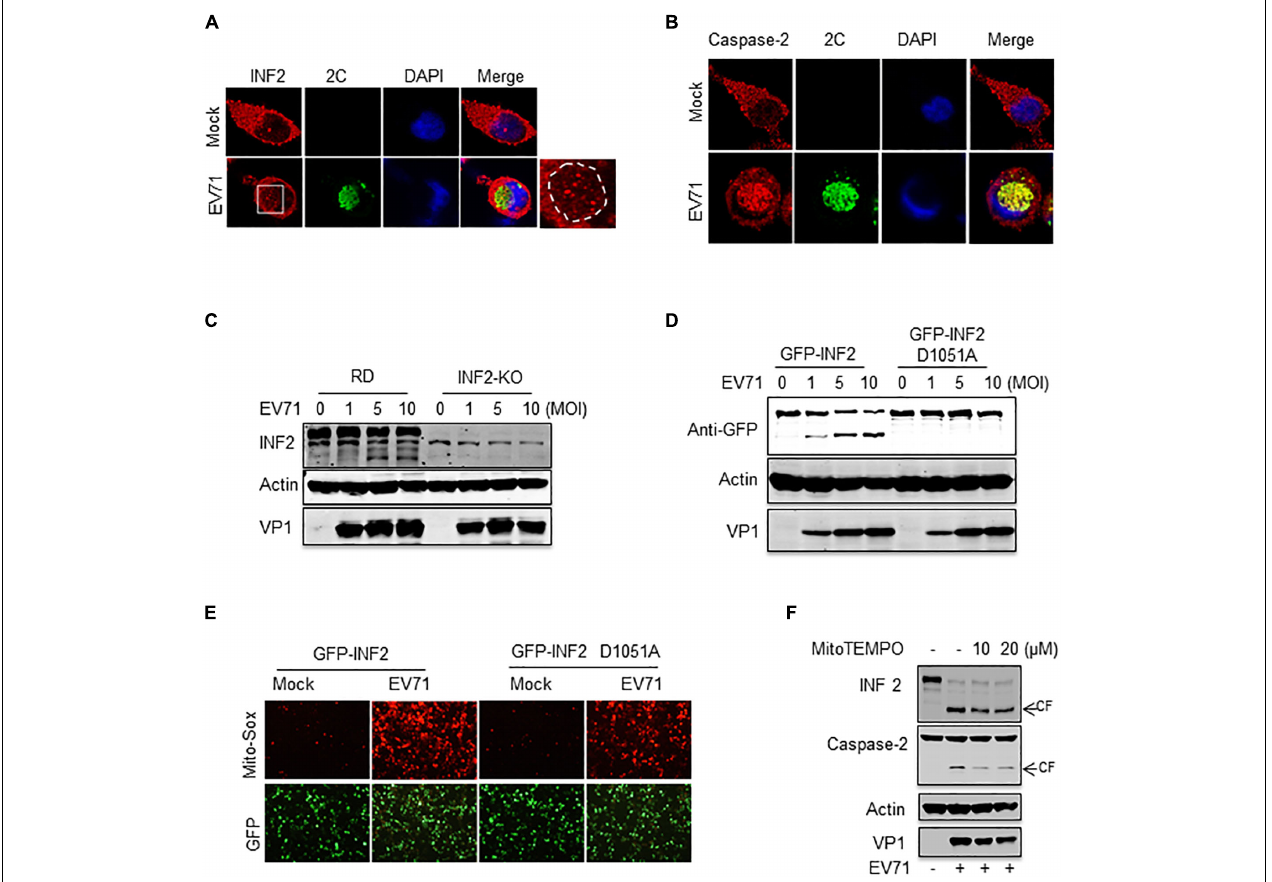
FIGURE 7 | Caspase-2-mediated INF2 cleavage participates in viral replication and is the cause of mitochondrial damage. (A) RD cells were mock-infected or infected with EV71 (MOI = 10) for 12 h, and immunostaining was then performed to detect the intracellular distribution of INF2 and EV71 2C protein (INF2, red; 2C, green; nuclei, blue). Insets show magnified views of the red channel in the boxed region. (B) RD cells were treated as described in (A) , immunostaining was performed to detect the intracellular distribution of caspase-2 and EV71 2C protein (caspase-2, red; 2C, green; nuclei, blue). (C) RD cells and INF2 knockout RD cells (INF2-KO) cells were infected with the indicated dosage of EV71. The cells were then harvested, and Western blotting was performed using the indicated antibodies to detect INF2, actin and EV71 VP1. (D) INF2-KO RD cells were transfected with plasmids encoding GFP-INF2 or GFP-INF2 (D1051A). Twenty-four h after transfection, the cells were infected with the indicated dosage of EV71 and then harvested for Western blotting using the indicated antibodies. (E) INF2-KO RD cells were transfected with plasmids encoding GFP-INF2 or GFP-INF2 (D1051A). Twenty-four h after transfection, the cells were mock-infected or infected with EV71 (MOI = 10) for 12 h; then, the cells were stained with Mito-Sox (red) and photographed using a fluorescence microscope. (F) RD cells were mock-infected (EV71–) or infected with EV71 (MOI = 10) for 12 h in the absence of (–) or with MitoTEMPO (+) of the indicated concentrations. The cells were then harvested, and Western blotting was performed using the indicated antibodies to detect INF2, caspase-2, actin, and EV71 VP1. Arrows indicate the cleavage fragments